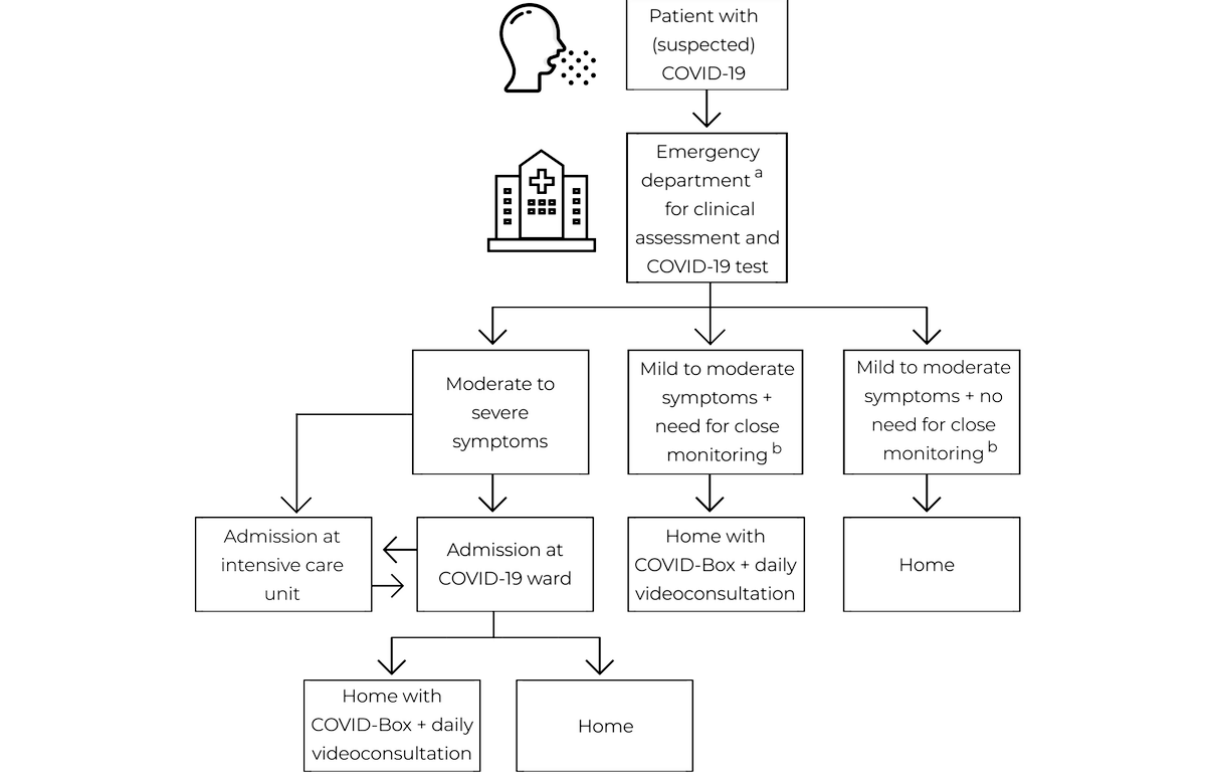
Figure 1. Types of patient journeys for individuals with (suspected) COVID-19. In the Netherlands, patients are only assessed at the emergency department after referral by their general practitioner or treating medical specialist (indicated by "a"). The treating physician eventually decides which patients are in need for close monitoring (indicated by